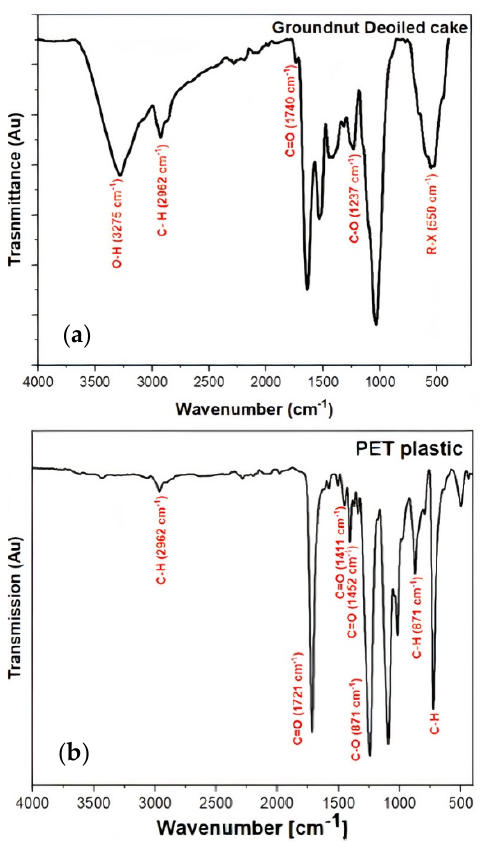
Figure 1. FTIR analysis of ( a ) Groundnut de-oiled cake ( b ) PET plastic.